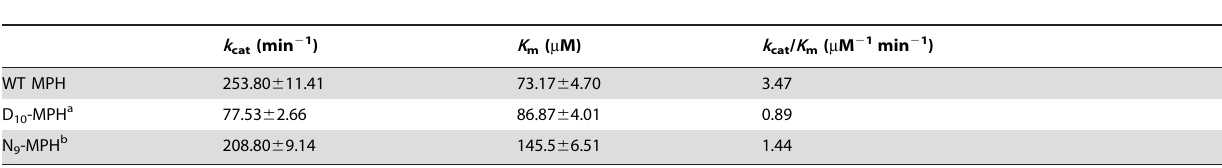
Table 2. The kinetic parameters of WT and mutant MPH.